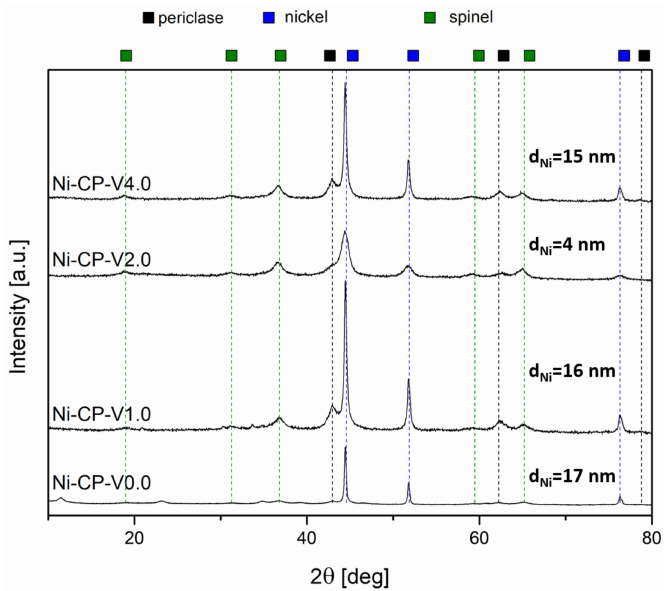
Figure 7. XRD diffractograms for spent hydrotalcite-derived